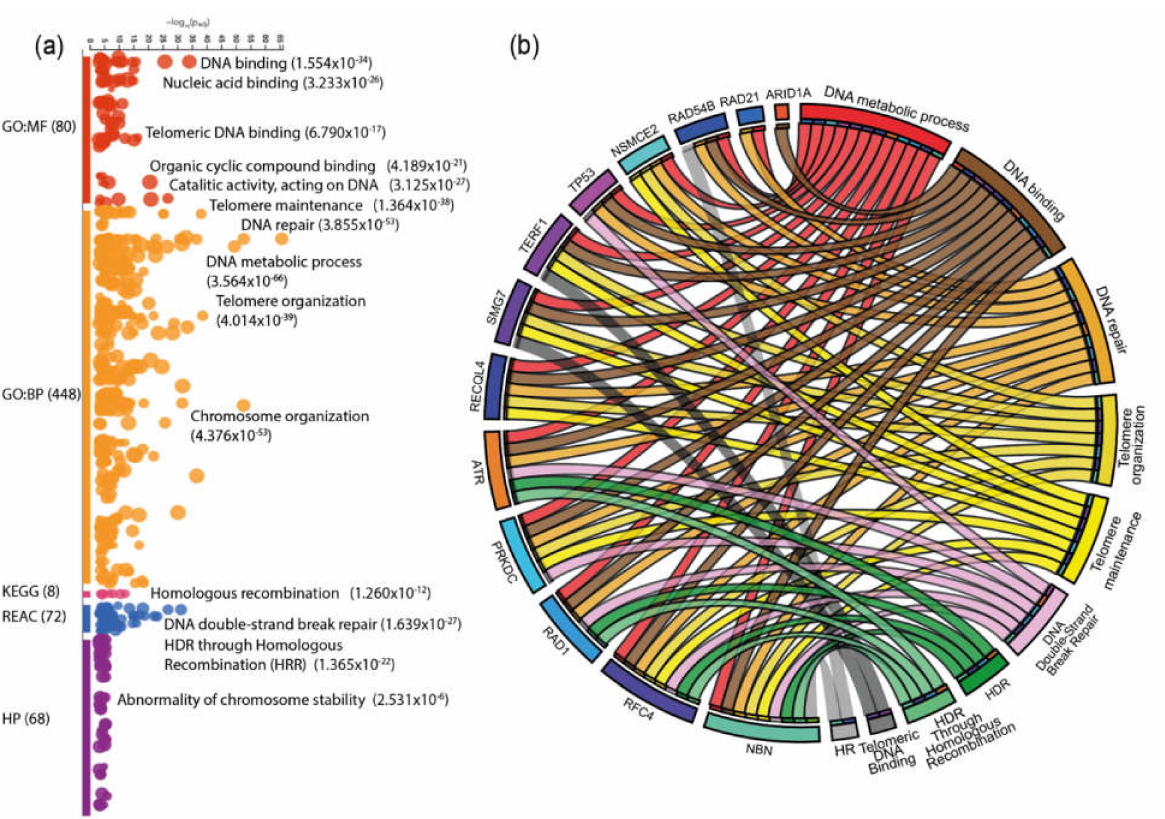
Figure 6. Enrichment analysis and protein-pathway correlation. ( a ) Shows the enrichment profile of 103 proteins; the most significant pathways for MF, BP, KEGG, Reactome, and HP are also shown next to the dots with its p -values. ( b ) Shows a CIRCOS plot corelating the genes with the highest means of alterations with its most significant pathways from the protein enrichment analysis. KEGG: Kyoto Encyclopedia of Genes and Genomes; HP: Human